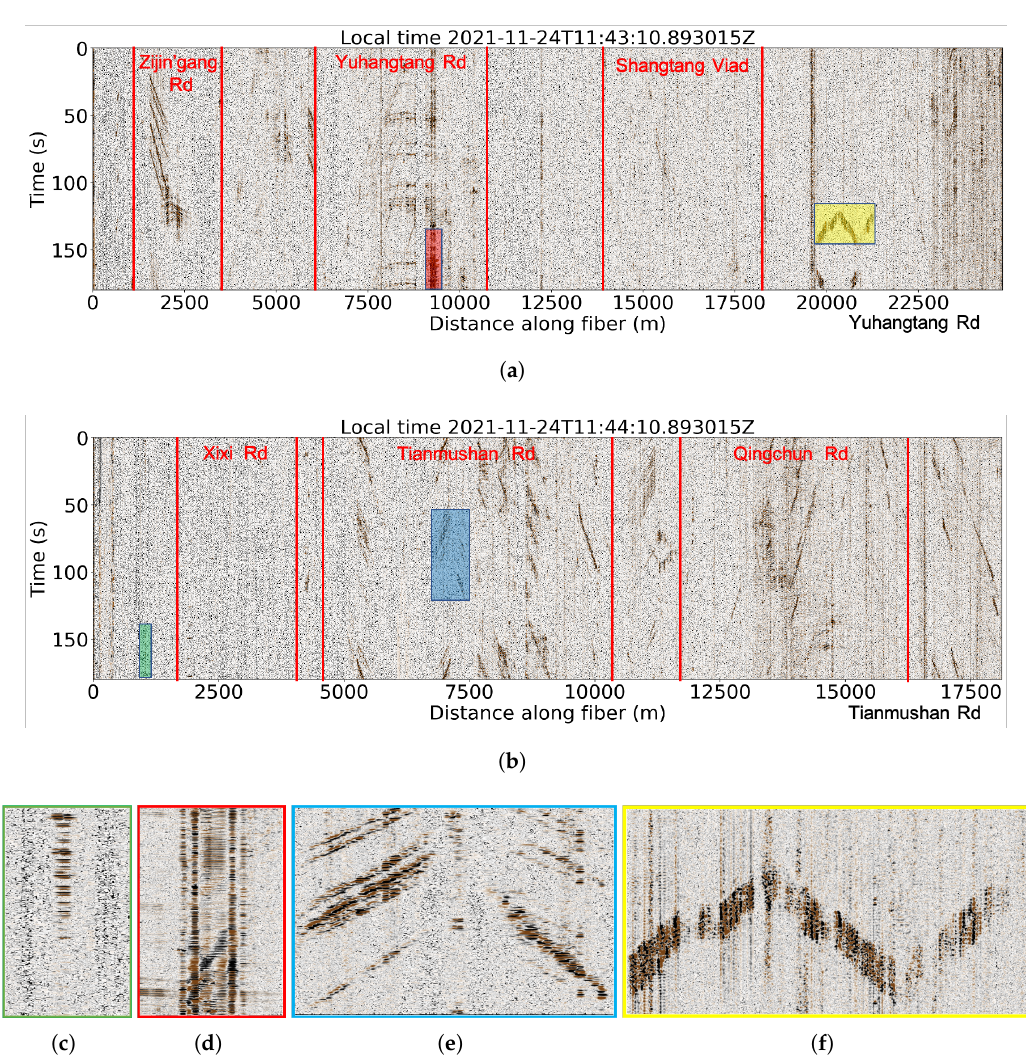
Figure 3. DAS data recordings from ( a ) north and ( b ) south lines. Characteristic urban DAS signals from ( c ) vehicles moving across optical fiber at the intersection, ( d ) bridge, ( e ) vehicles moving parallel to the optical fiber, and ( f )